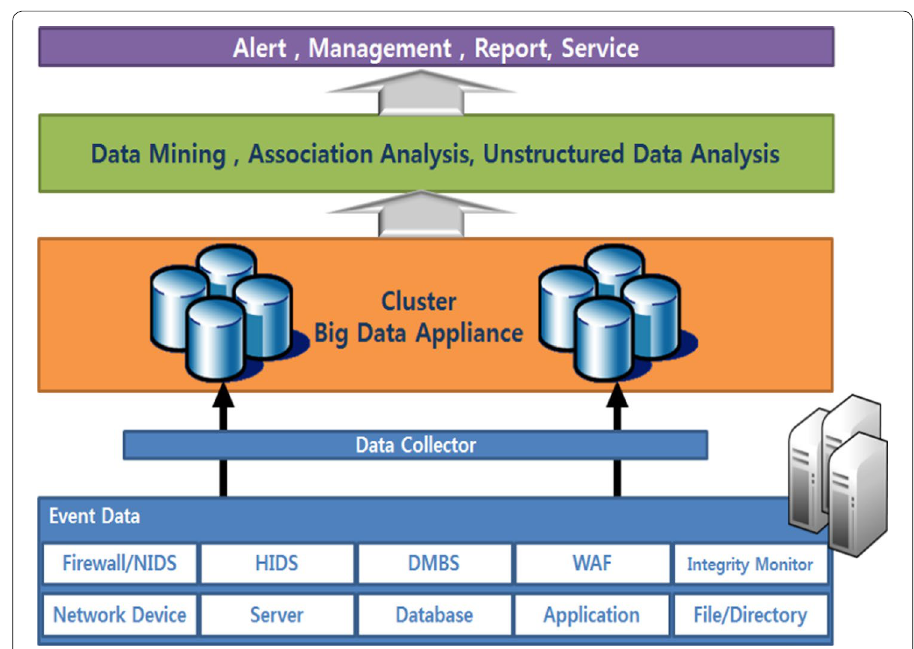
Fig. 6 Big data proposed model for IDS optimization [17,